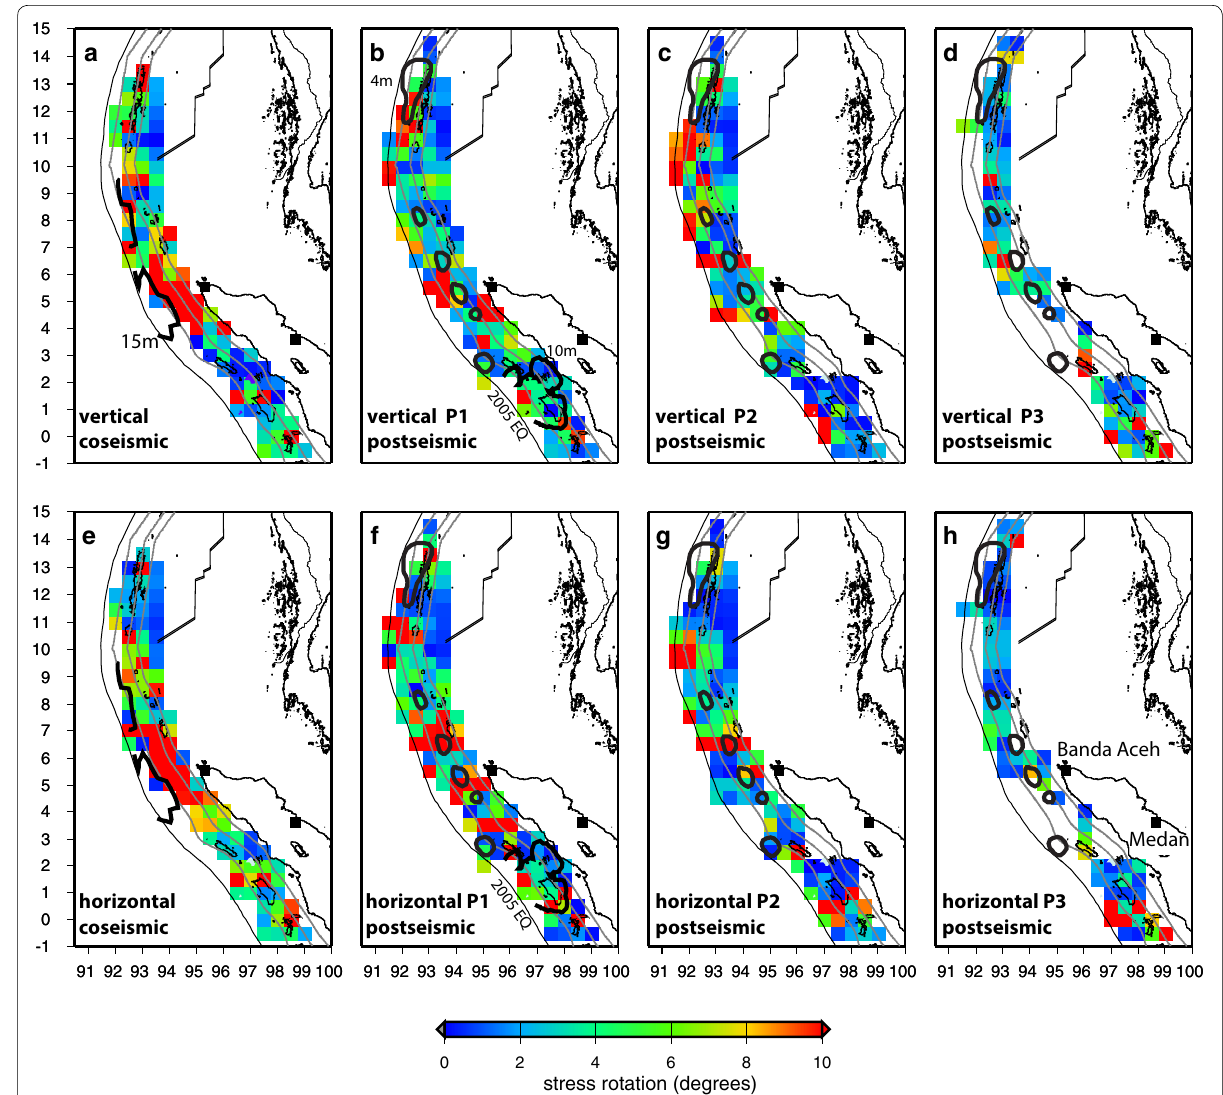
Fig. 3 Stress rotations following the 2004 M9.3 Sumatra–Andaman earthquake. a Vertical coseismic rotation, the change between the pre-main- shock (1977-5-20–2004-12-26) and first postmainshock (2004-12-26–2005-3-28) time periods. Thick black lines indicate the 15-m contour of the 2004 M9.3 mainshock slip model of Rhie et al. (2007), b vertical postseismic rotation P1, between the first and second (2005-3-28–2007-9-12) postmain- shock time periods. Thick black lines indicate the 4-m contour of the postseismic slip model of Chlieh et al. (2007), and the southernmost contour is the 10-m contour of the 2005 M8.6 Nias–Simeulue earthquake slip model of Ji (2005), c vertical postseismic rotation P2, between the second and third (2007-9-12–2012-4-11) postmainshock time periods, d vertical postseismic rotation P3, between the third and fourth (2012-4-11–2016-9-17) postmainshock time periods, e horizontal coseismic rotation, f horizontal postseismic rotation P1, g horizontal postseismic rotation P2, h